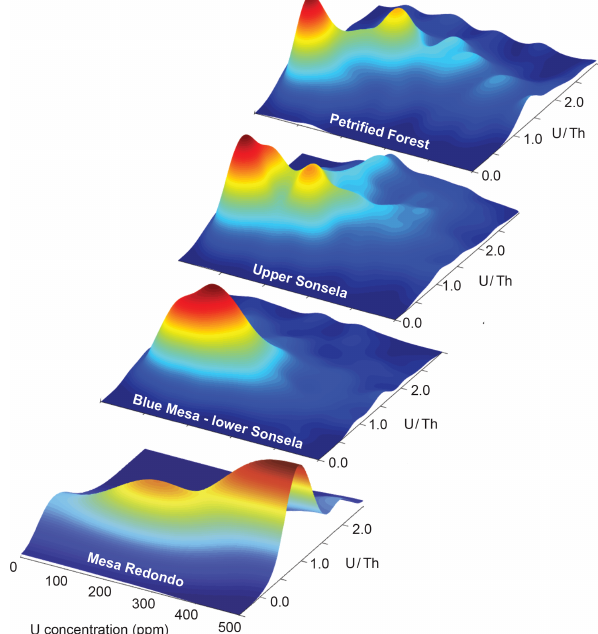
Figure 10. Density distributions of U concentration versus U / Th for Triassic grains in the four chronostratigraphic units recognized in this study. Plots were made with hafnium (Hf) density plotter software of Sundell et al.